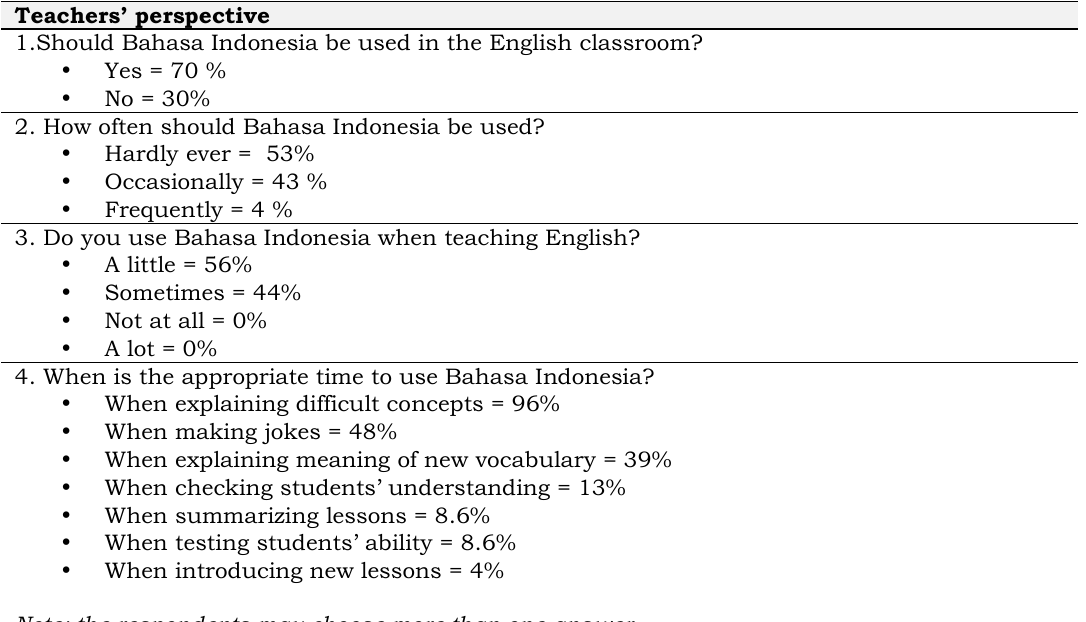
Table 1. Teachers’ responses to the